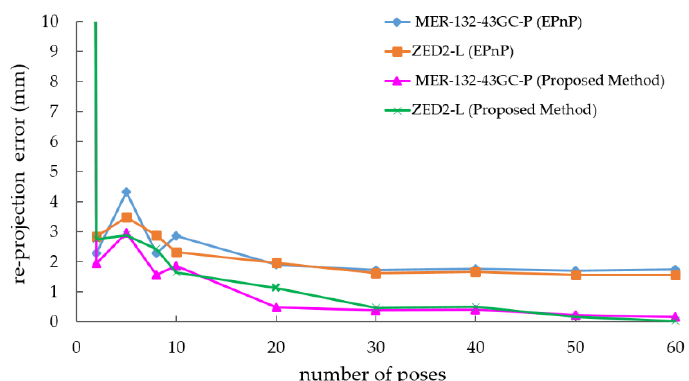
Figure 11. Re-projection error of normalized plane with different number of poses.